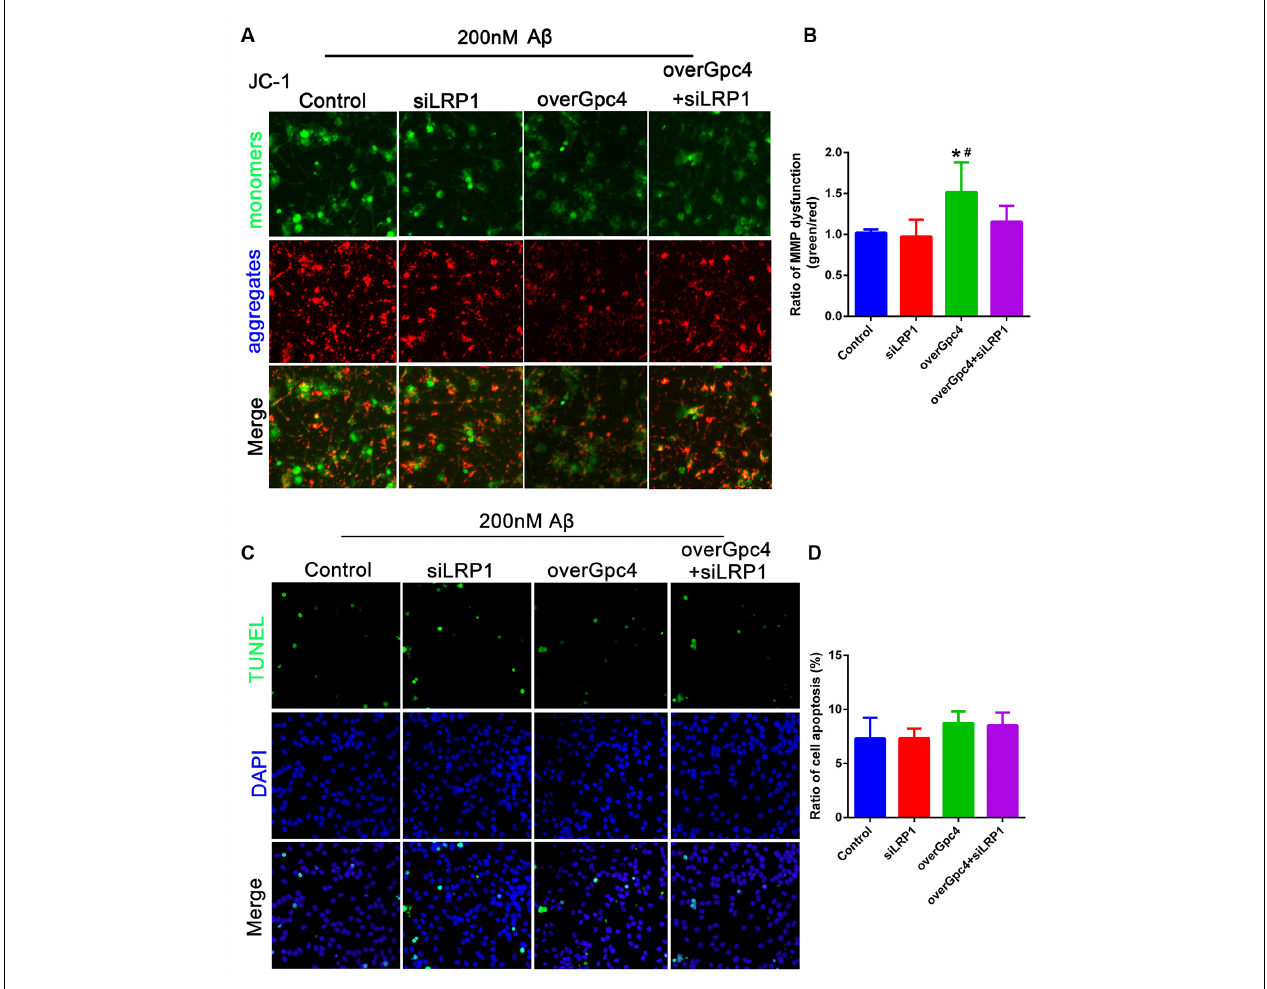
FIGURE 8 | Role of Gpc4 and LRP1 on 200 nM A β on NSCs. (A,B) NSCs were infected with control, siLRP1, overGpc4, and overGpc4 + siLRP1 AdV for 3 days, and then 200 nM A β was added for 12 h. The JC-1 kit was used to detect the mitochondrial membrane potential in NSCs. JC-1 monomers (green) and aggregates (red) were compared and normalized to those of the control group. The ratio of monomers/aggregates was calculated. * represents overGpc4 vs. control, P = 0.0036, # represents overGpc4 vs. siLRP1, P = 0.0080. (C,D) NSCs were infected with control, siLRP1, overGpc4, and overGpc4 + siLRP1 AdV for 3 days, and 200 nM A β was added for 12 h. TUNEL staining was used to detect whether Gpc4 regulated the A β -induced cell death via LRP1. The ratio of apoptotic cells was calculated based on TUNEL positive cells (green) and DAPI (blue). NSCs, neural stem cells; GPc4, glypican 4; LRP1, low-density lipoprotein receptor related protein 1; AdV, adenovirus; TUNEL, terminal deoxynucleotidyl transferase dUPT nick end labeling; DAPI, 4 (cid:48)